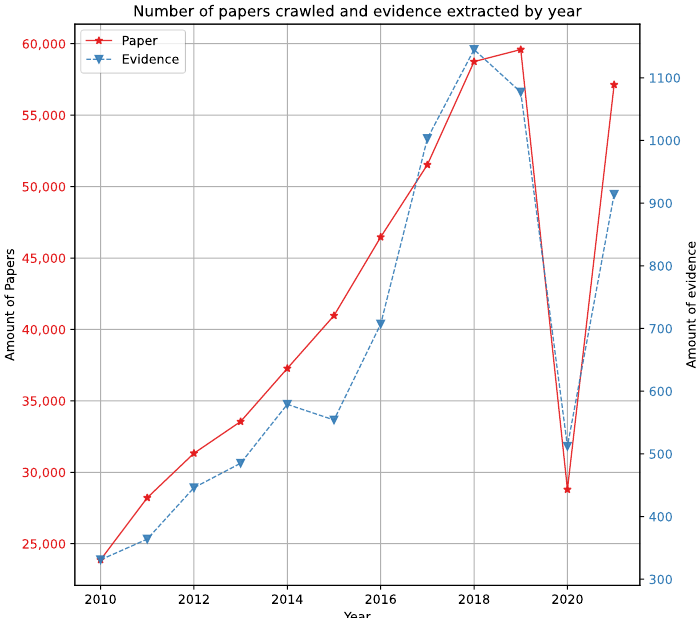
Figure 1. Number of papers crawled, and evidence extracted by year.